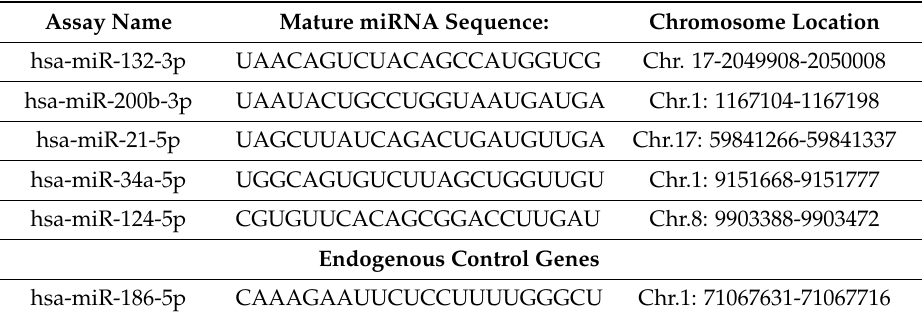
Table 3. Tested miRNAs in this